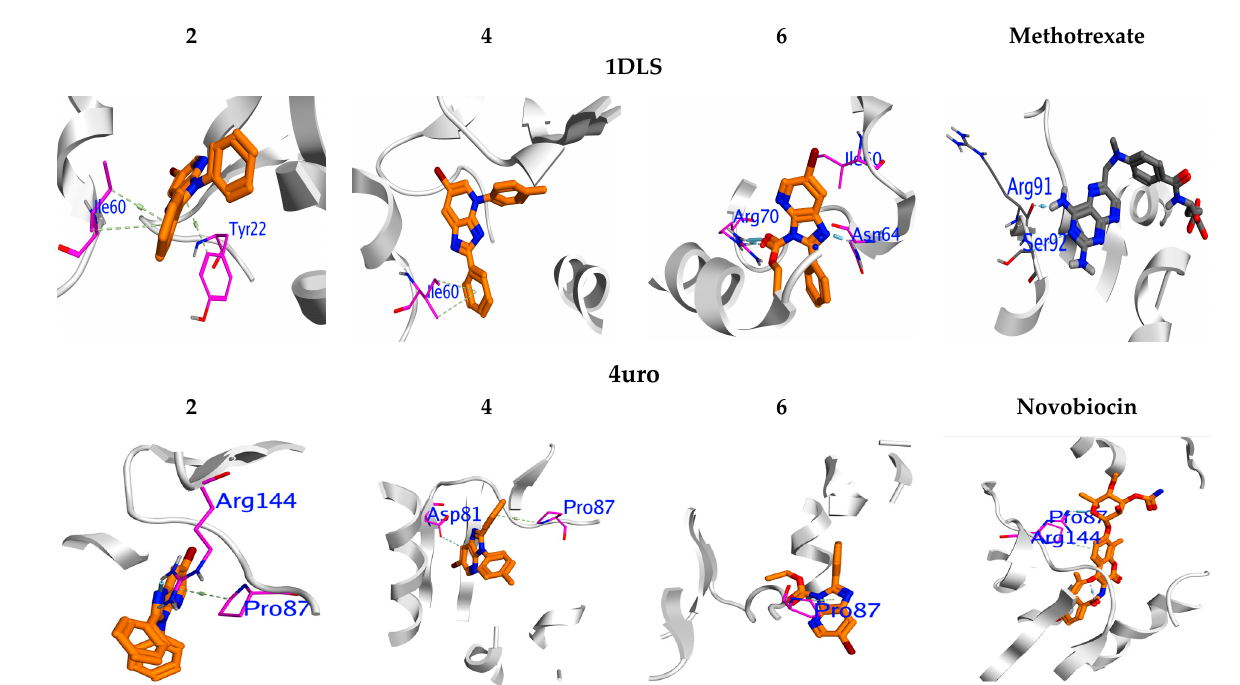
Figure 10. Three-dimensional mapping surface for 2 , 4 , 6 and reference inhibitors inside the active sites of PDB:1DLS and PDB: 4uro.